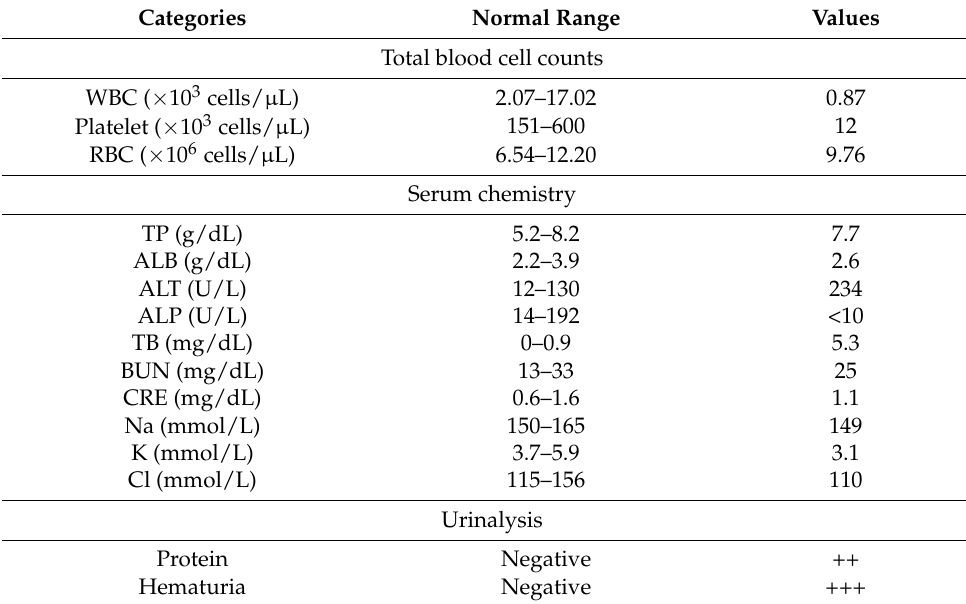
Table 2. Total blood cell counts and serum chemistry of the sick